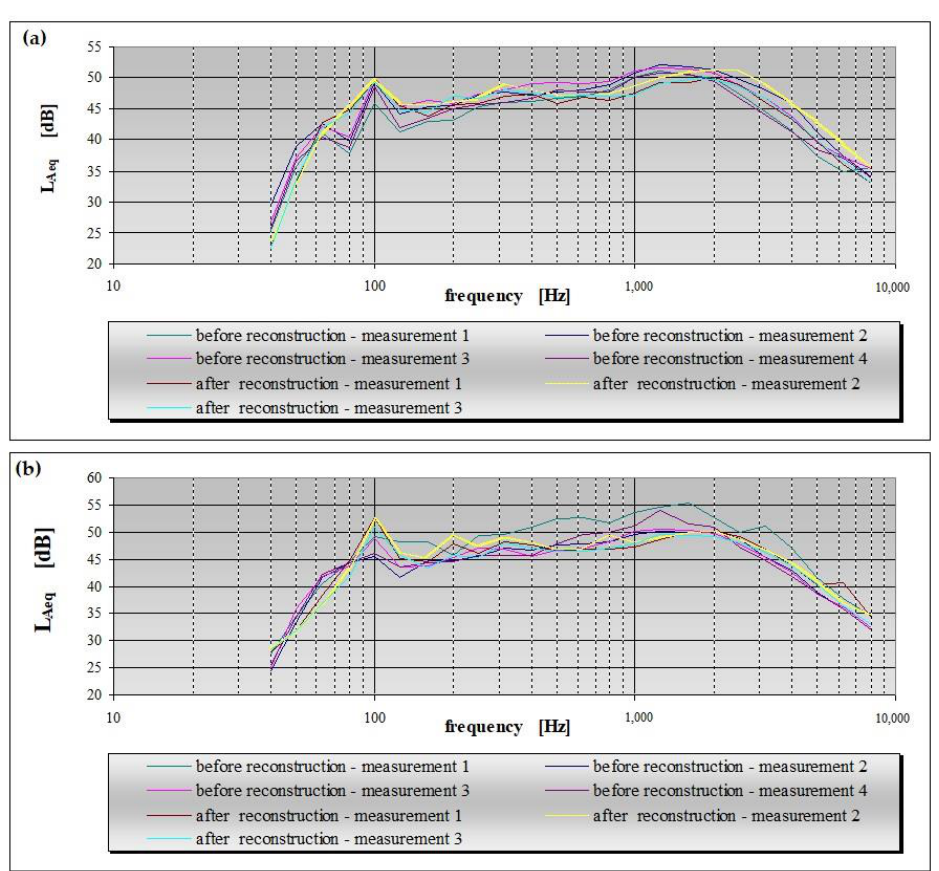
Figure 6. Comparison in the 1–3 octave bands of equivalent noise level L Aeq from road traffic before and after the reconstruction of intersections in Michalovce: ( a ) R1 and ( b ) R2. Measurements of the noise load in the city of Žilina revealed a decrease in noise levels after the reconstruction of the three-arm intersection into a roundabout. Reductions in the noise level were by 3.4 dB at monitoring station MS1 and 2.9 dB at MS2. Measurements after five years of use of the roundabout revealed a slight increase in the noise load in the vicinity of the intersection. Compared to the original three-arm intersection, the decreases were 2.6 dB at MS1 and 2.1 dB at MS2 (Table 8, Figure 7). Table 8. Equivalent noise levels at the assessed points obtained from modeling L Aeq,day , L Aeq,evening , and L Aeq,night and from real measurements L Aeq,day,m conducted in Žilina city.